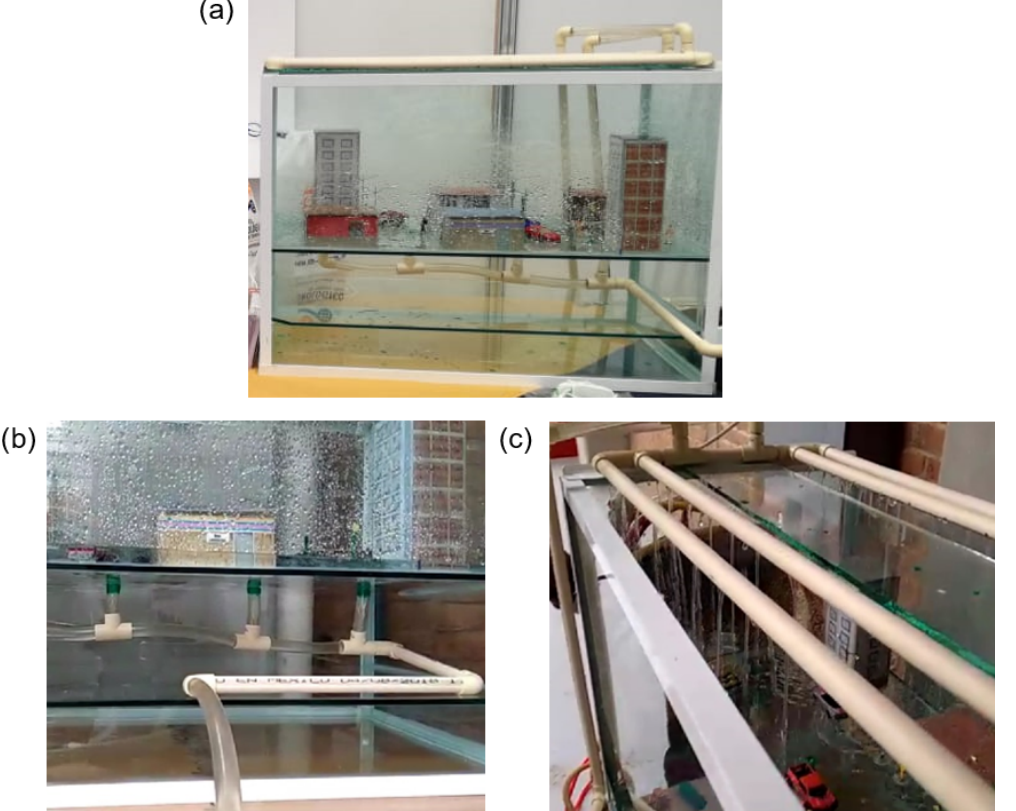
Figure 4. Details of the urban water physical model constructed for the OH-Kids workshop: (a) glass case with representation of small-scaled city, (b) urban drainage system, and (c) rainfall simulator.